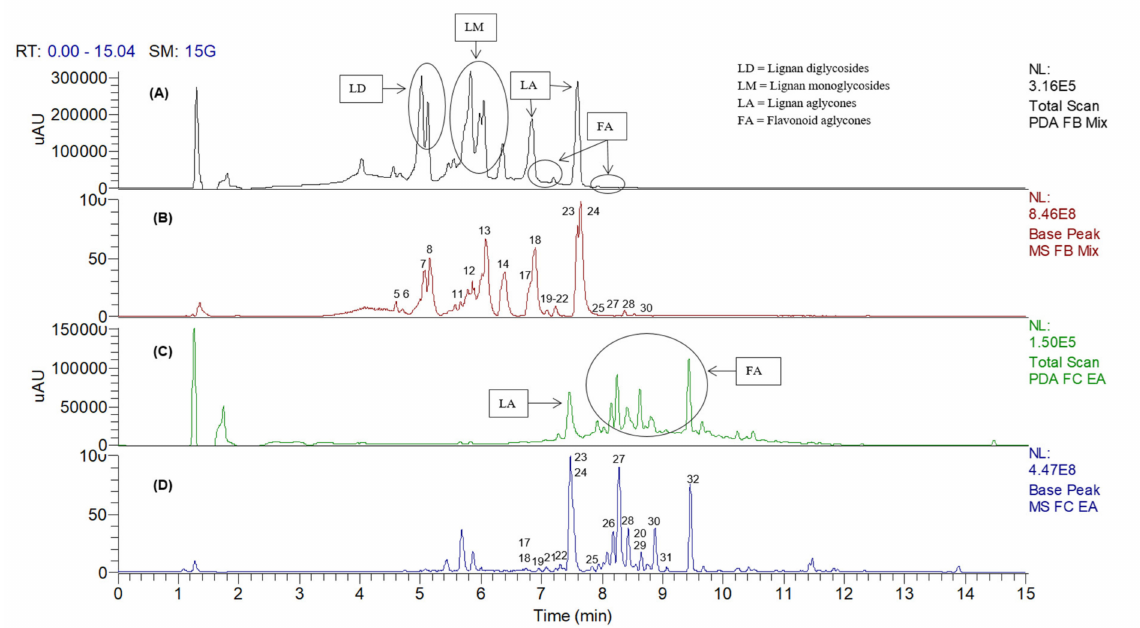
Figure 3. The LC–DAD and LC–MS base peak chromatogram profiles of the 50% MeOH ( A , B ) and EA ( C , D ) fractions of Clitorea ternatea roots, in negative ion